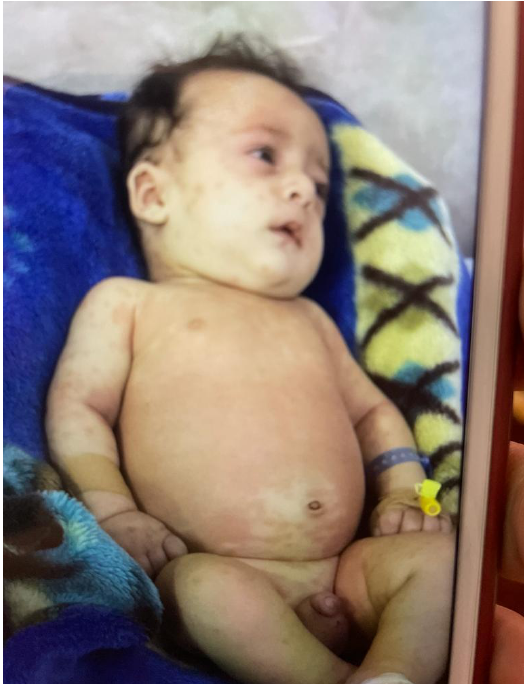
Figure 1: dehydrated baby with generalized non-pitting edema and macular non-blanching skin rash all over the body